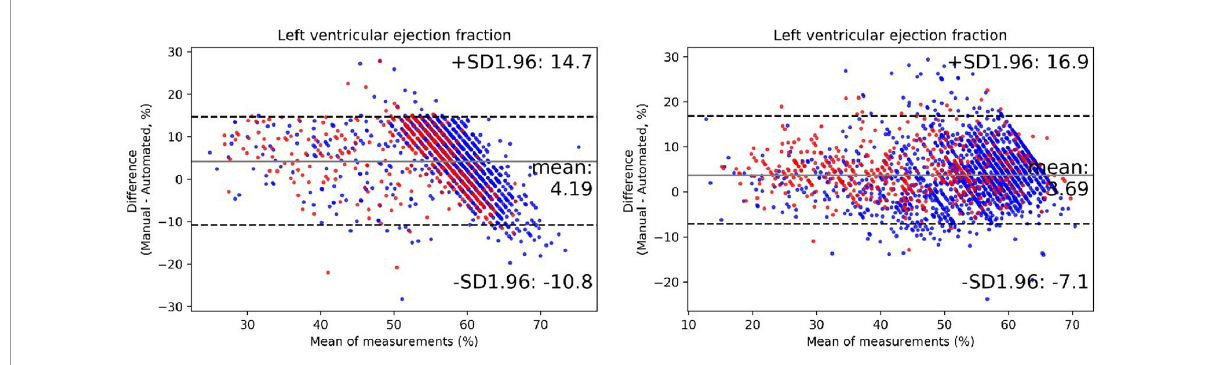
FIGURE5 The performance of the automated quantification model. Bland–Altman plots of left ventricular ejection fraction in repeated measurements using the exact same video clips of internal (left plot) and external (right plot) testing dataset. The red dots represent cases acquired from portable bedside ultrasound; the blue dots represent cases acquired from standard ultrasound. The black lines represent limits of